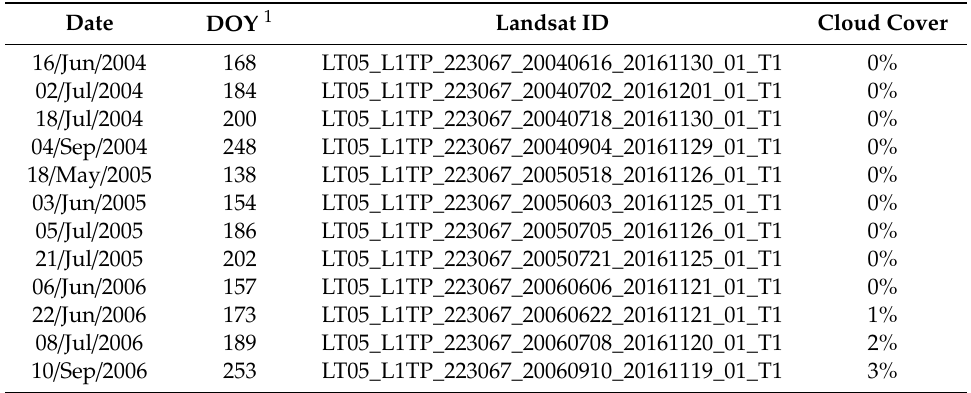
Table 2. Description of the Landsat 5 Thematic (TM) images used to implement the Surface Energy Balance Algorithm for Land